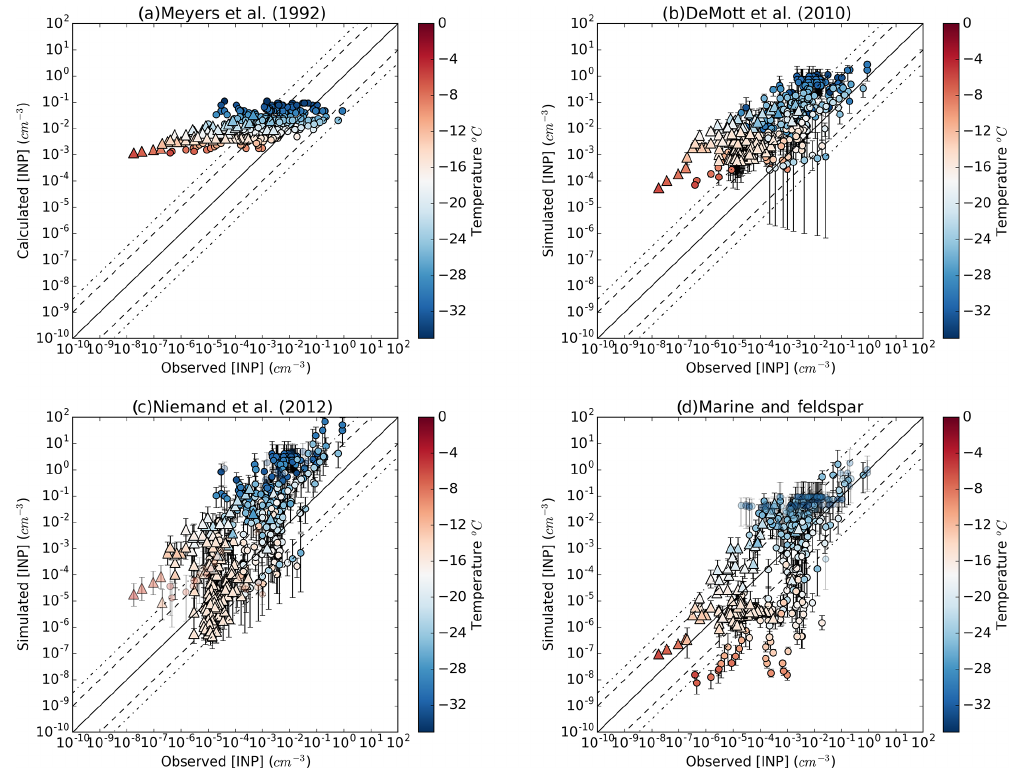
Figure 8. Comparison of the performance of a variety of INP parameterizations tested against field measurements. (a–d) Modelled INP concentration values when using (a) Meyers parameterization (Meyers et al., 1992), (b) DeMott’s parameterization (DeMott et al., 2010) combined with a global aerosol simulation using GLOMAP mode, (c) Niemand dust parameterization (Niemand et al., 2012) and (d) our two- species representation based on feldspar (Atkinson et al., 2013) and marine organic aerosols (Wilson et al., 2015). Triangles represent marine influenced regions and points terrestrial environments. The light shaded points in (d) and (e) are for data points outside the temperature range of the parameterizations. The dashed lines represent one order of magnitude of difference between modelled and observed and the dashed- dotted lines 1.5 orders of magnitude. The simulated values correspond to an annual mean concentration and the error bars correspond to the simulated seasonality of INPs calculated with monthly mean values. For each individual observation, we calculated the INP concentration at the temperature corresponding to the temperature that aerosol particles were exposed to in the INP instruments. The locations of the data point are shown in Fig.